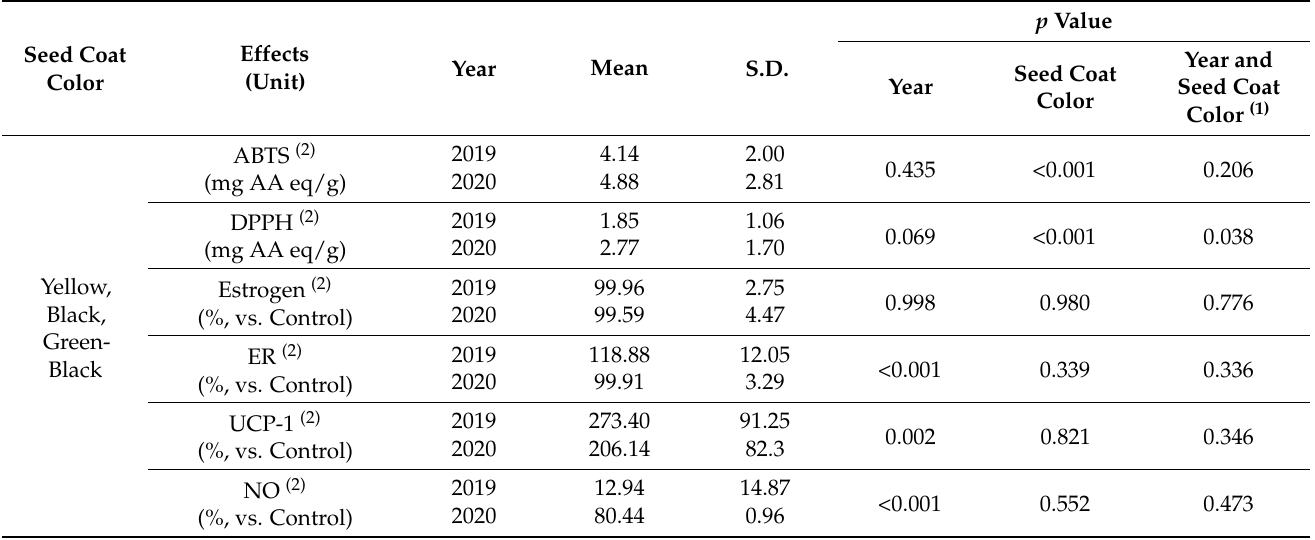
Table 2. ANOVA for the six effects of 48 soybean germplasm in 2019 and